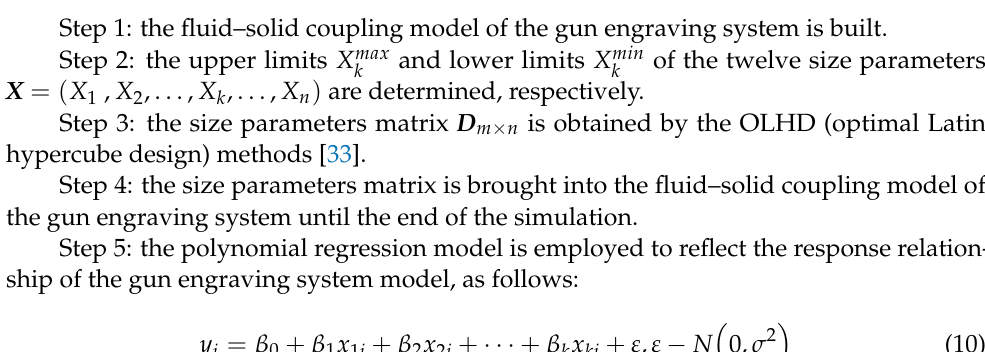
Figure 19. Flow chart of the sensitivity analysis